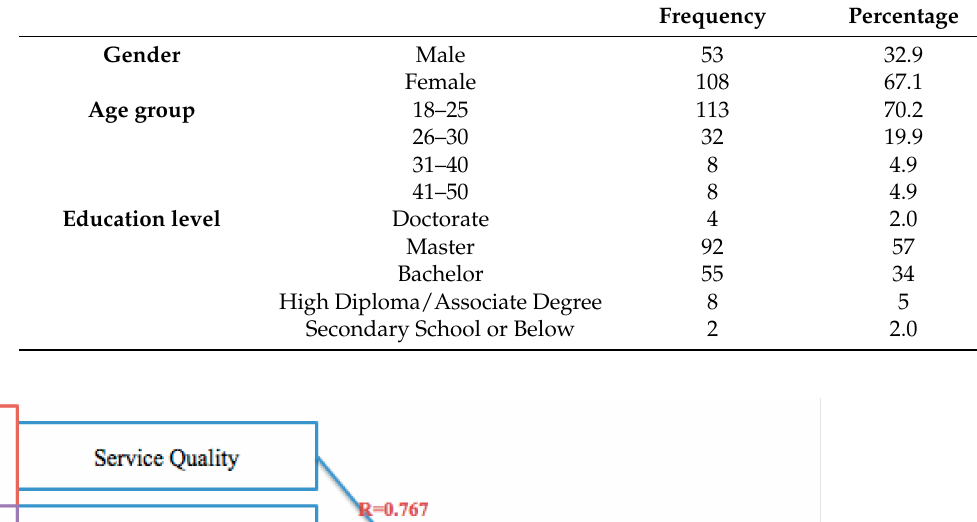
Table 4. Demographic data of respondents.